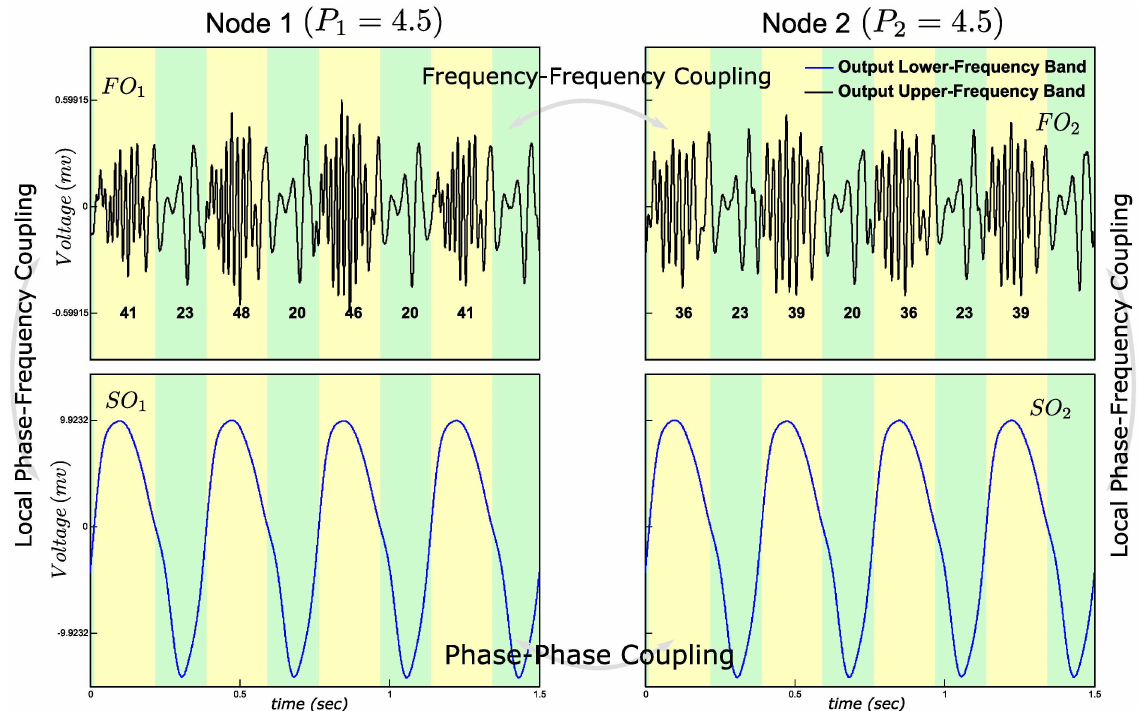
Fig 4. Frequency-Frequency Coupling (FFC) simulation. The frequencyof FO 1 and FO 2 varies for the synchronized SO 1 and SO 2 . Integers below the FO time waves are the averagenumberof zero crossings, which is an index of averagefrequency of each phase. The numbers change betweenpositive and negativephases of synchronizedSO 1 and SO 2 . Local PFC betweenFO 1 and SO 1 , and betweenFO 2 and SO 2 are also